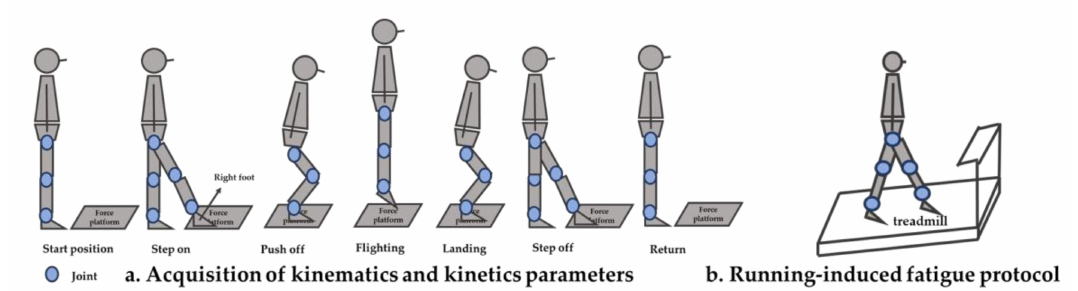
Figure 1. Illustration of the entire experiment. Sequence: ( a ) pre-fatigue, ( b ) fatigue protocol, ( a )